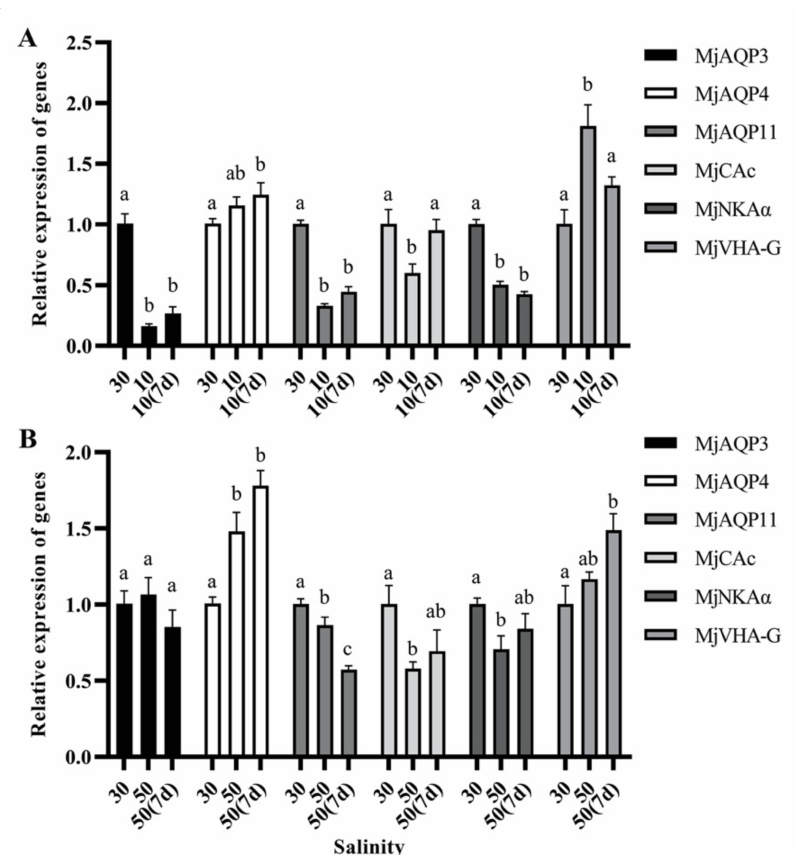
Figure 5. The relative expression levels of genes during the low-salinity ( A ) and high-salinity ( B ) acclimation periods in the post-larvae shrimp. The relative expression level of each gene at 30‰ salinity is separately used as calibrator. The data are presented as mean + SD ( n = 3). Lowercase letters indicate significant differences ( p < 0.05) with each